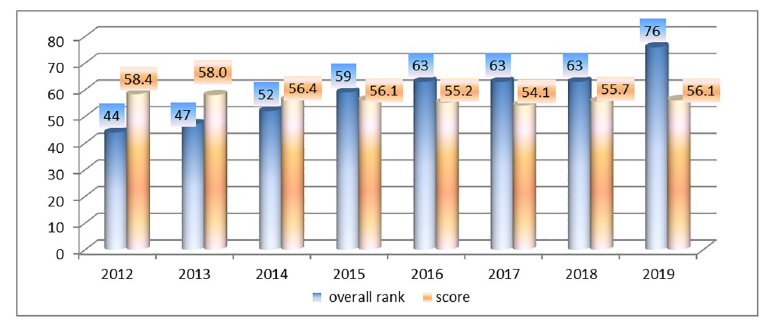
Fig 1. Dynamics of the Global Food Security Index of Ukraine. Source: [63, 73–80]. Overall rank (0–113 where 1– most favourable); Score—weighted total of all category scores (0–100 where 100 –most favourable).